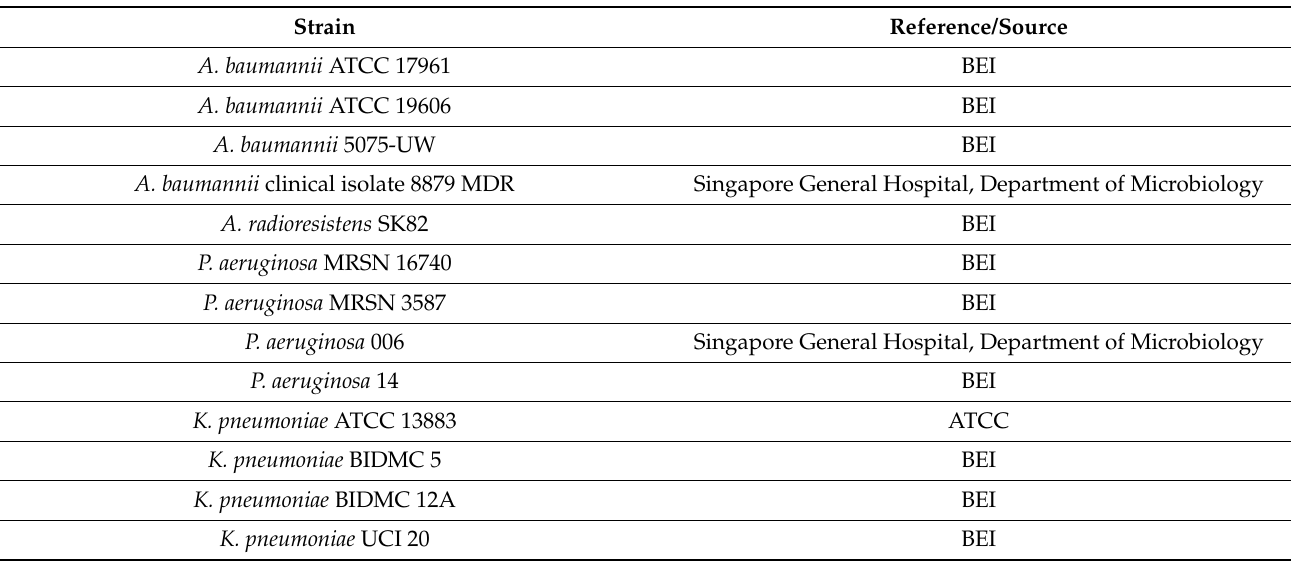
Table 1. Bacterial strains employed in this study. Strain